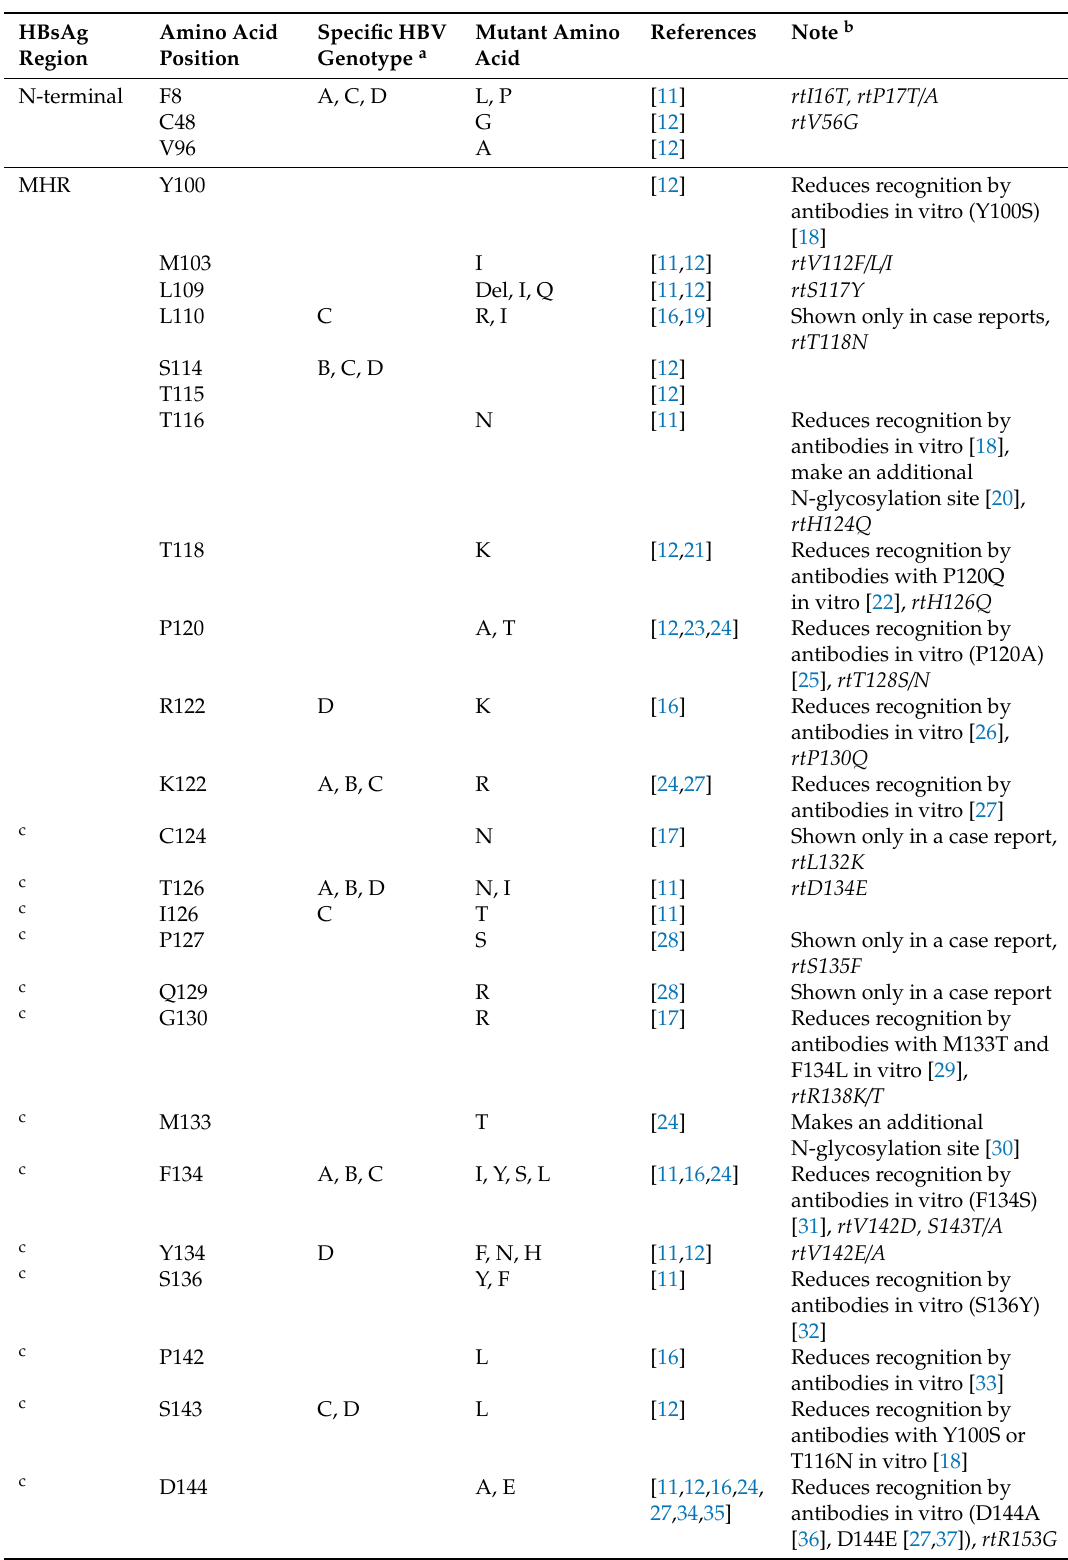
Table 1. Reported mutations of HBsAg that were found in HBV-reactivated patients with chemotherapies / immunosuppression therapies. HBsAg Amino Acid Specific Region